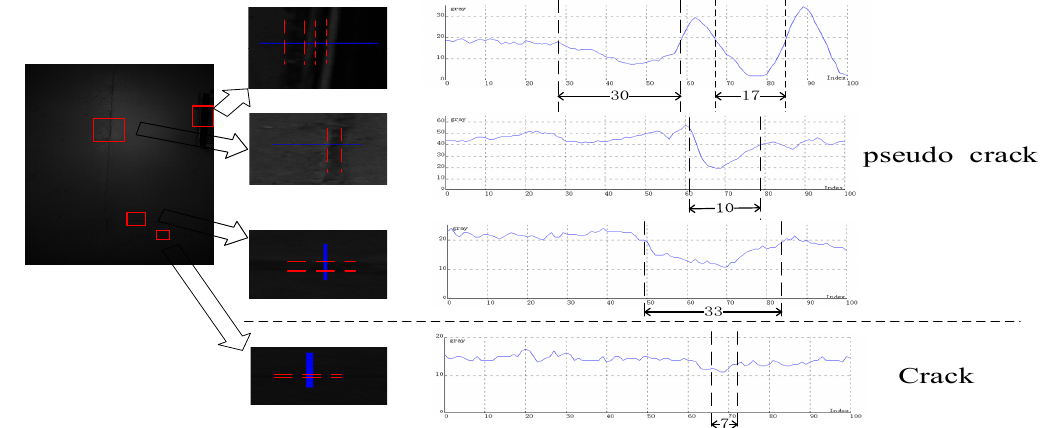
Figure 3. Lines of various widths in the tunnel lining image and its profile gray curve.